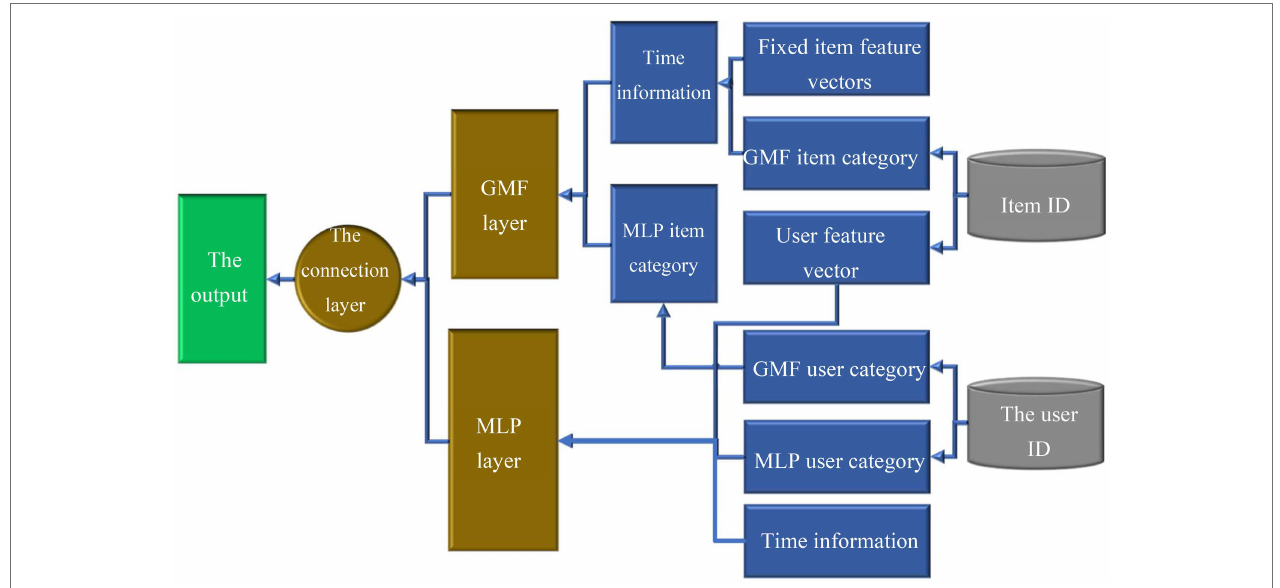
FIGURE 6 | Improved Neu MF